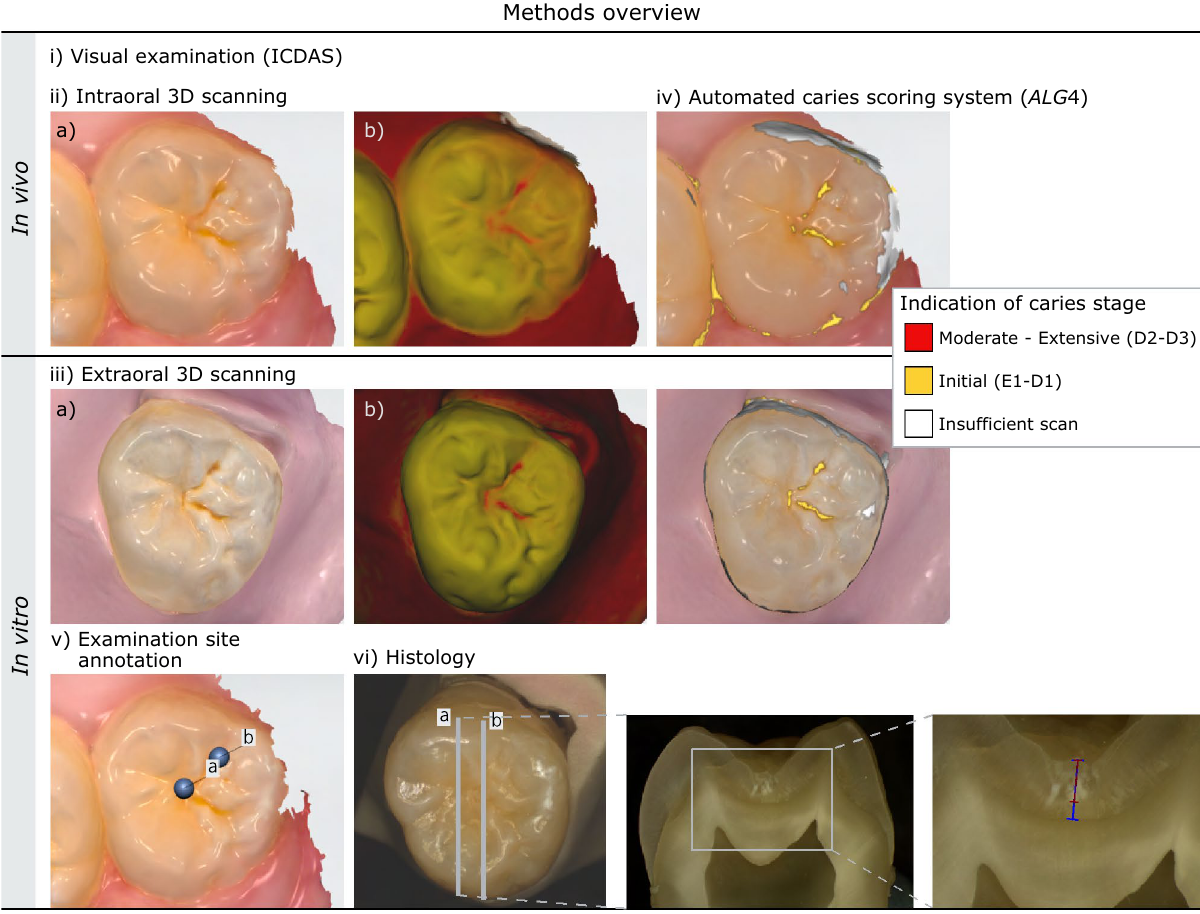
Figure 1. Study methods overview in vivo and in vitro. 3D models of the same tooth scanned (iia) in vivo and (iiia) in vitro using white light; the tooth color signal was mapped onto the models. The same tooth was scanned (iib) in vivo and (iiib) in vitro with the 415 nm wavelength light, which excites fluorescence from the dental tissues. (iv) caries score indication based on TRIOS patient monitoring software (3Shape TRIOS A/S, Denmark) according to ALG4 . Indication of caries stages: Initial; caries lesions in enamel and outer third of dentin (Histology E1–D1). Moderate–extensive; caries lesions in middle and inner thirds of dentin (Histology D2– D3). Insufficient scan: insufficient data on tooth color and/or fluorescence that does not allow the automated caries score calculation. (v) selected examination sites ( a , b ) annotated on the 3D model. (vi) tooth sectioning lines corresponding to the examination sites ( a , b ) for the histological assessment. On the tooth section, the red measurement line corresponds to the demineralization depth and the blue measurement line corresponds to the enamel